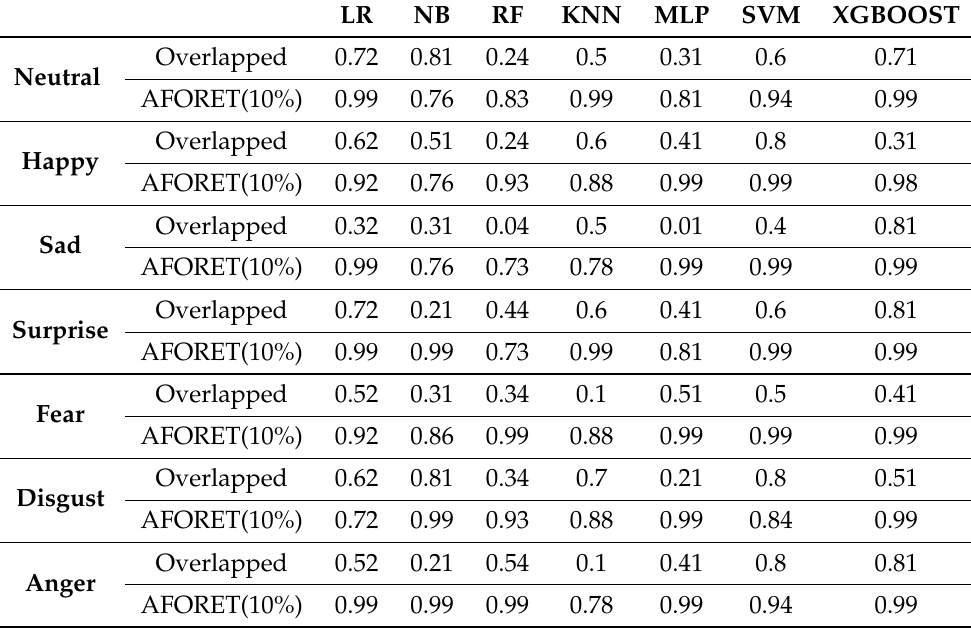
Table 8. Accuracy achieved by classifiers for all emotion classes before and after applying